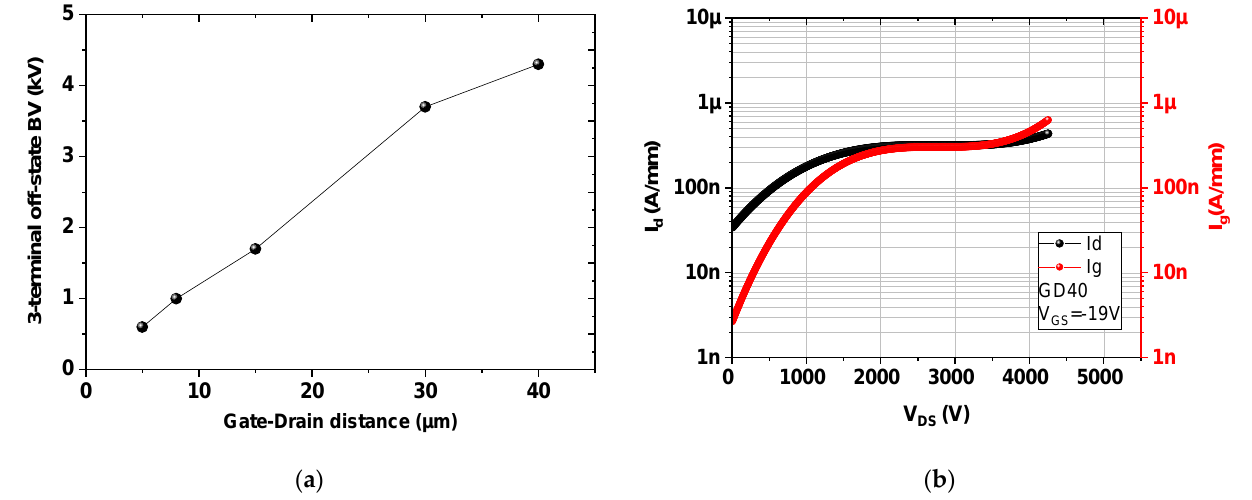
Figure 6. Three-terminal off-state BV for various GD distances ( a ) and for a gate-drain distance of 40 µm ( b ) of AlN/AlGaN/AlN HEMTs.